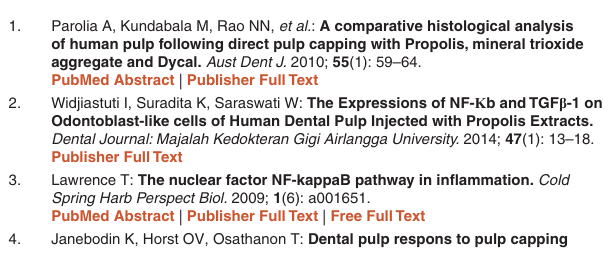
- Figure S1. Mean of IL-10, VEGF, IL-8, TGF- β and TLR-2 expressions on the 7th day . - Figure S2. Mean of IL-10, VEGF, IL-8, TGF- β and TLR-2 expressions on the 14th day . - Figure S3. Immunohistochemical examination results from VEGF. A. Control, B. Negative Control, C. Therapy with Ca(OH) , D. Therapy with a combination of propolis 2 and Ca(OH) . 2 - Figure S4. Results of immunohistochemical examination of IL-10. A. Control, B. Negative Control, C. Therapy with Ca(OH) , D. Therapy with a combination of propolis and 2 Ca(OH) . 2 - Figure S5. Immunohistochemical examination results from TGF- β . A. Control, B. Negative Control, C. Therapy with Ca(OH) , D. Therapy with a combination of propolis 2 and Ca(OH) . 2 - Figure S6. Results of immunohistochemical examination of TLR-2. A. Control, B. Negative Control, C. Therapy with Ca(OH) , D. Therapy with a combination of propolis and 2 Ca(OH) . 2 - Figure S7. Results of immunohistochemical examination of IL-8. A. Control, B. Negative Control, C. Therapy with Ca(OH) , D. Therapy with a combination of propolis and 2 Ca(OH) 2